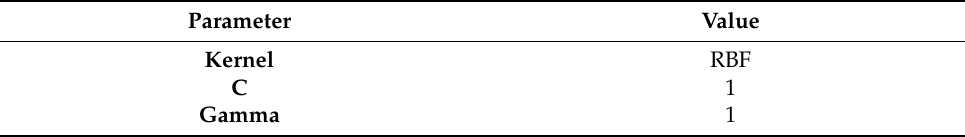
Table 12. Hyperparameters for SVM.